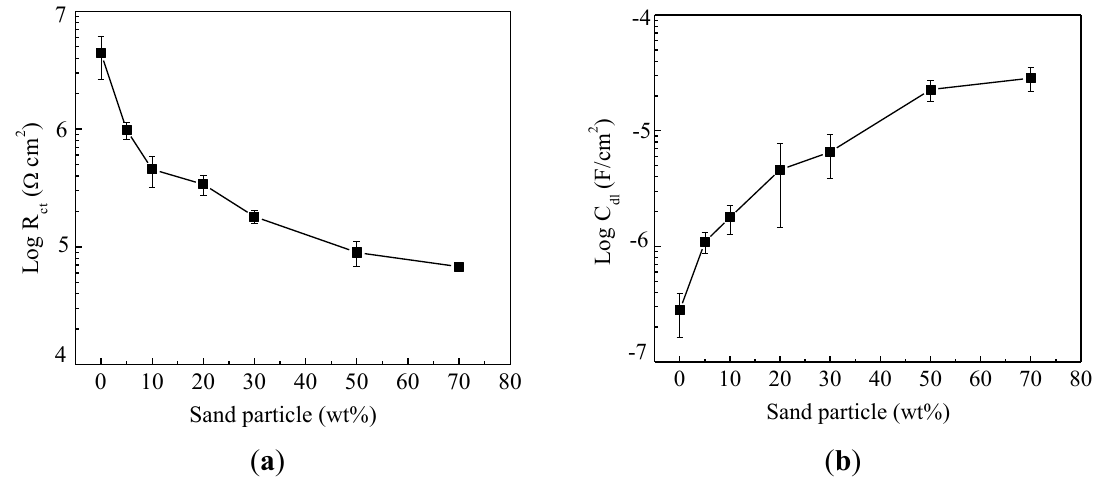
Figure 6. The effect of sand particle contents on: ( a ) charge transfer resistance; and ( b ) double-layer